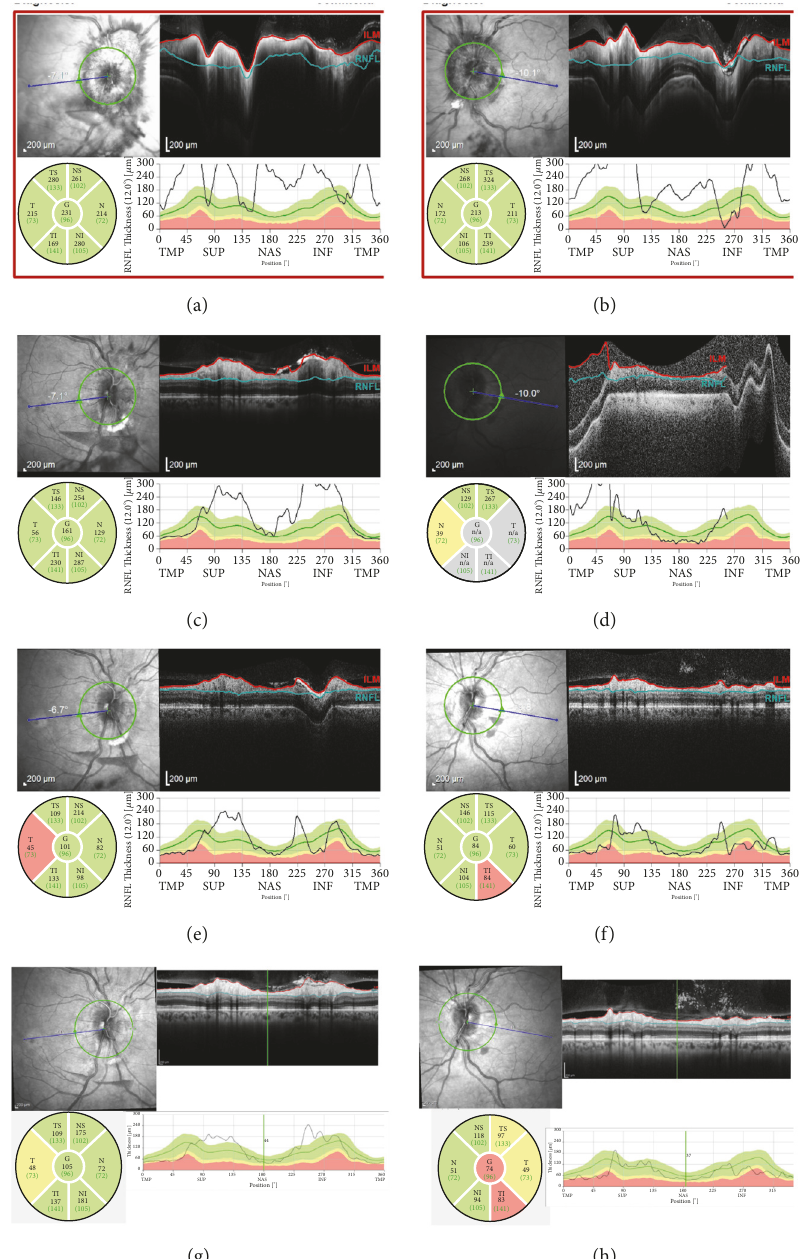
Figure 2: Retina Nerve Fiber Layer (RNFL) Optical Coherence tomography (OCT) of the (a, c, e, g) right eye and (b, d, f, h) left eye showing (a, b) disc edema at presentation, (c, d) improving disc edema at six-week follow-up, and (e, f) near resolution of disc edema at twelve weeks and (g, h) sixteen weeks. Sectoral thickness measured in microns, and thickness of cross-section in temporal (TMP), superior (SUP), nasal (NAS), and inferior (INF) graphed against normative population data